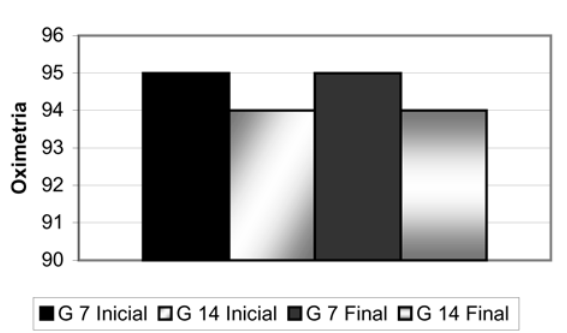
FIGURA 5 – Valores da oximetria no período inicial (prévio à desvascularização) e 10 minutos após desvascularização dos ratos dos grupos 7 e